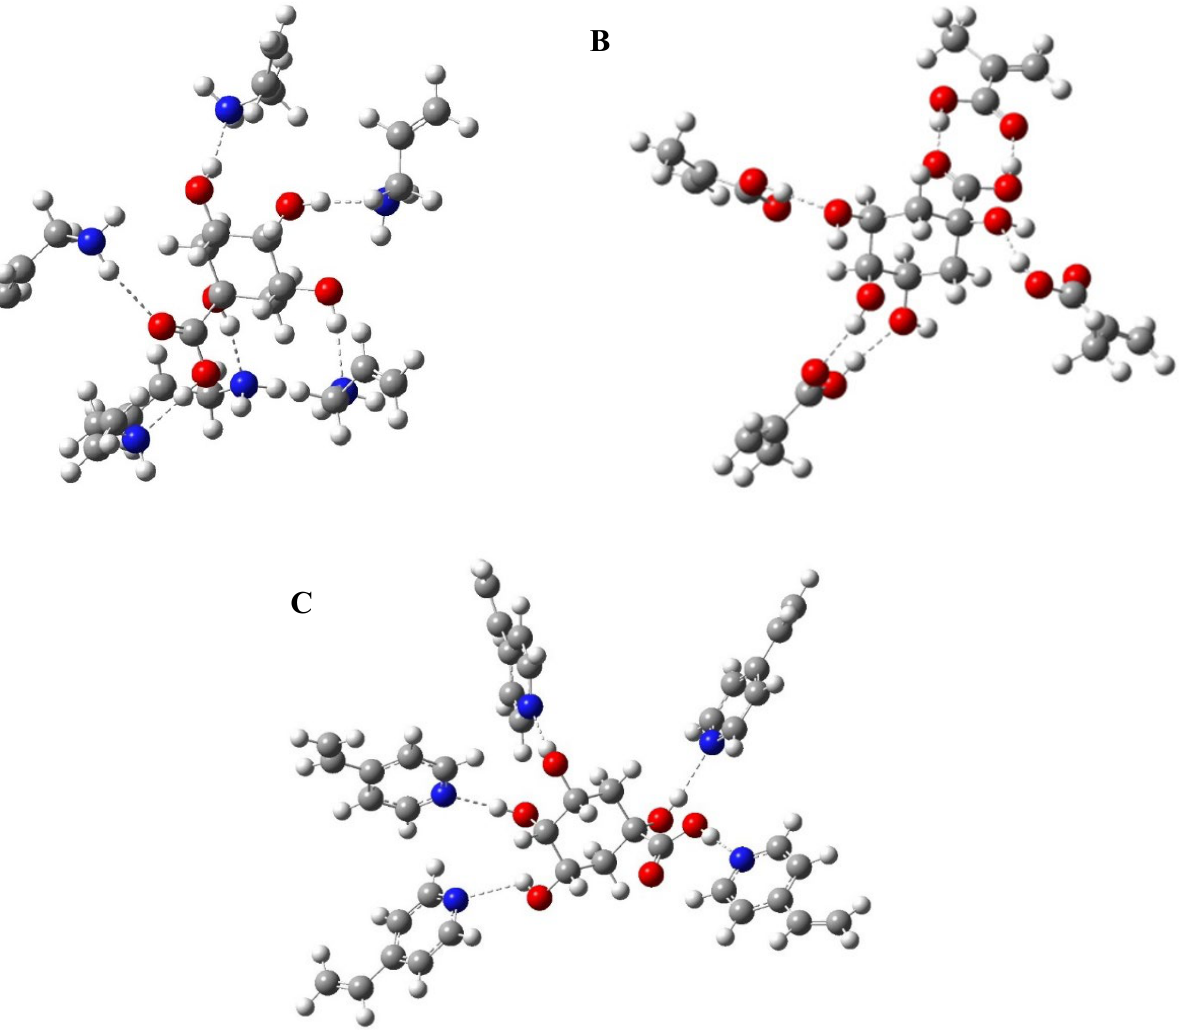
Figure 2. Computer-modelled structures of the best conformations for ( A ) QA–(allylamine) 6 , ( B ) QA–(MAA) 4 and ( C ) QA–(4-VP) 5 complexes. Energies of the most stable conformations were then determined and the binding energies of the formed complexes were calculated according to Equation (1) and the results are shown in supplementary data. Based on the binding energies; the best template: monomer ratio was determined for each functional monomer. Results revealed that by increasing the number of monomers used, the calculated binding energies increased, which indicates the formation of more stable complexes [60]. For allylamine, the best ratio was 1:6 ( E = − 175.909 kJ/mol). For MAA, it was 1:4 ( E = − 1633.061 kJ/mol). Finally, for 4-VP the optimum ratio was 1:5 ( E = − 136.5265 kJ/mol) (Figure 2). Accordingly, these ratios were chosen for the synthesis of MIPs and their corresponding NIPs to be used for further